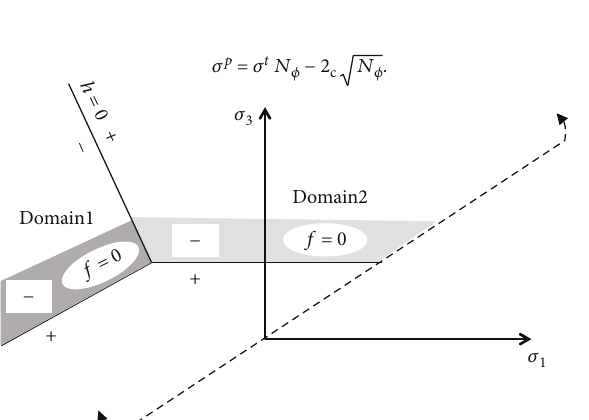
Figure 1: Mohr – Coulomb failure criteria.